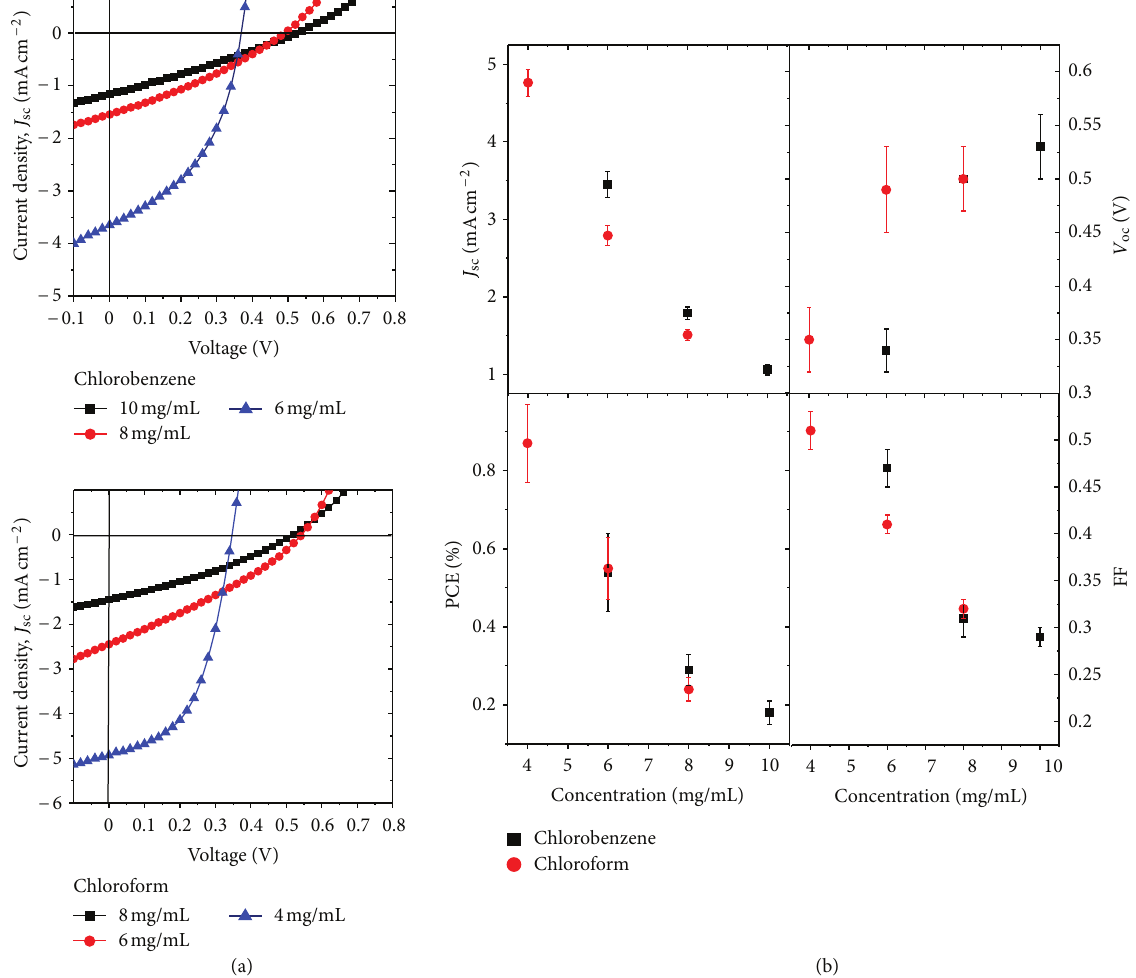
characteristicsofdevicespreparedfromdifferentCBandCFsolutionconcentrations,(b)photovoltaicparametersofdevices as a function of solution